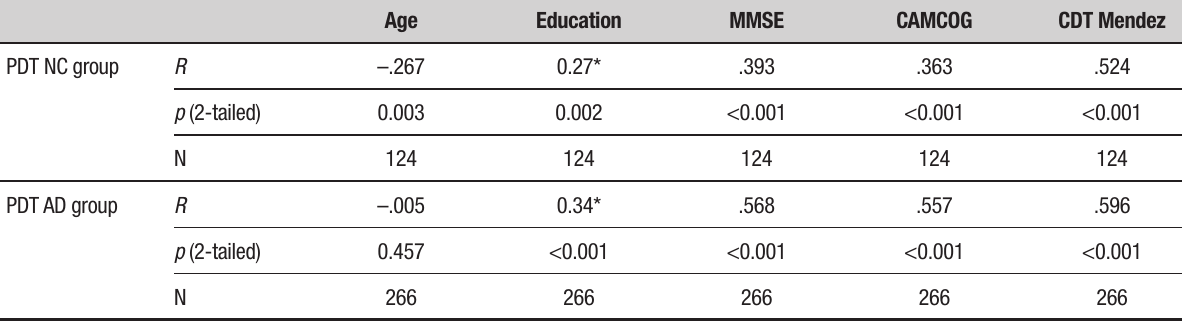
Table 3. Correlation between the PDT by Bourke et al. and age, education, MMSE total score, CAMCOG, and CDT.